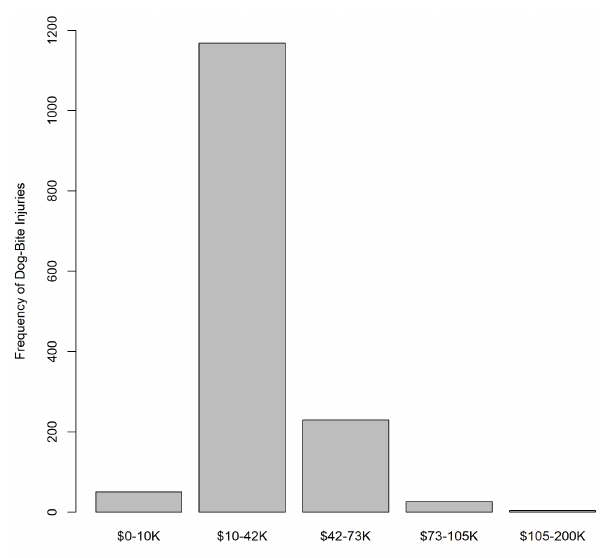
Figure 3. Distribution of dog bite injuries by level of annual income.